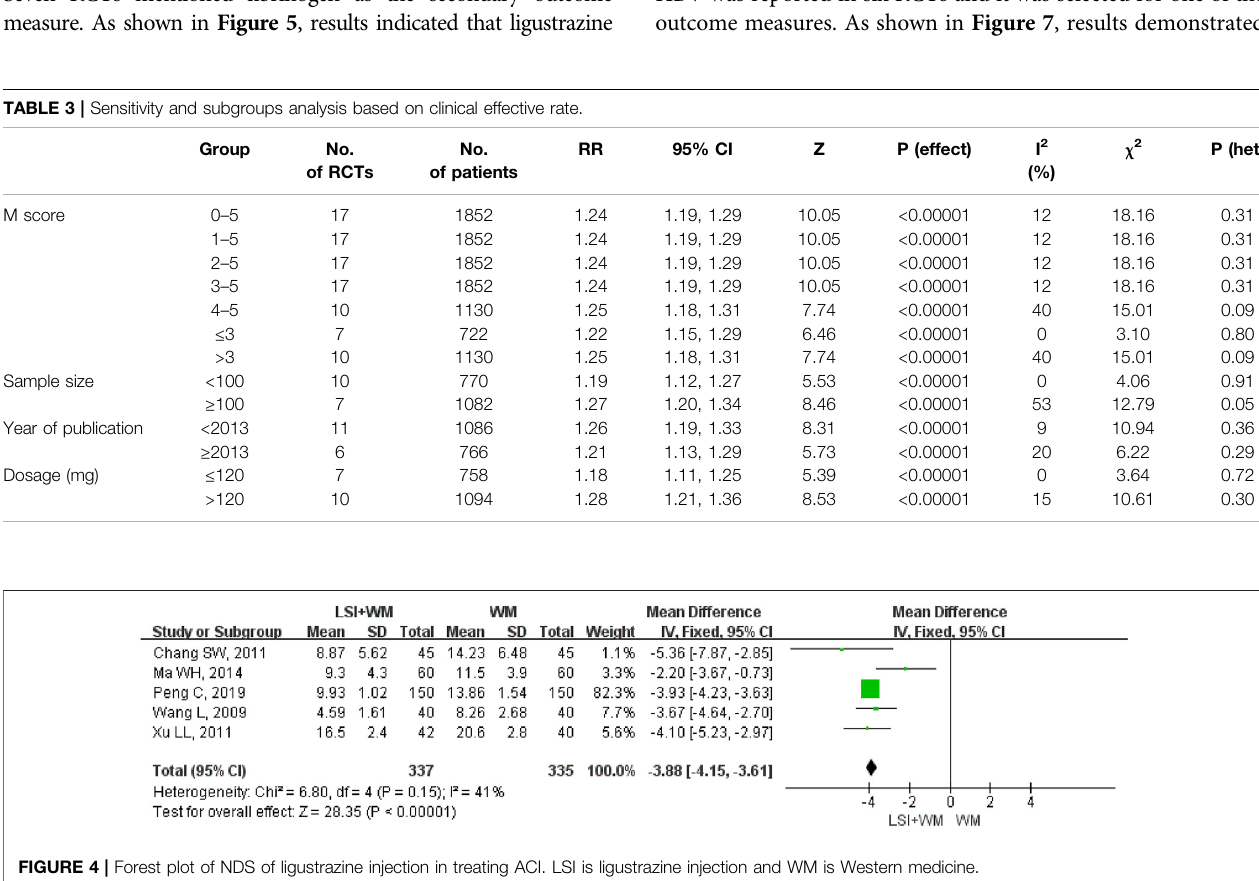
FIGURE 4 | Forest plot of NDS of ligustrazine injection in treating ACI. LSI is ligustrazine injection and WM is Western medicine.